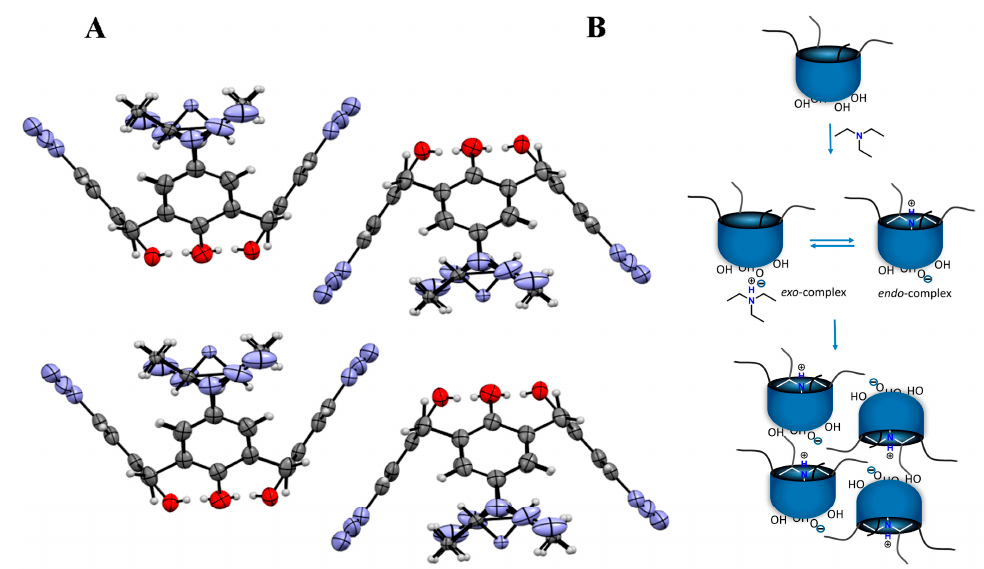
Figure 1. ( A ) ORTEP representation of 3 showing 20% probability thermal ellipsoids. C atoms—grey, O atoms—red, N atoms—blue. ( B ) Schematic representation of two different binding modes with triethylammonium cation.